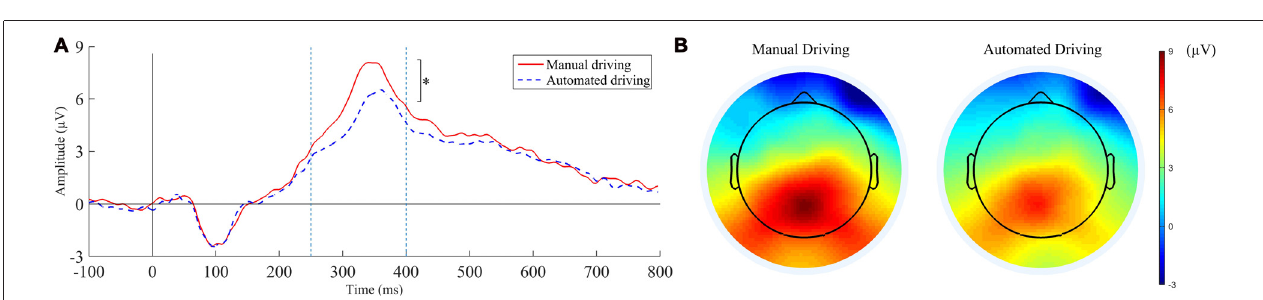
FIGURE 6 | P3 component grand average waveforms (A) and topographical distribution (B) in the manual and automated driving conditions. The time window used for the topographical representation was 270–400 ms after the stimulus onset. ∗ P < 0.05.